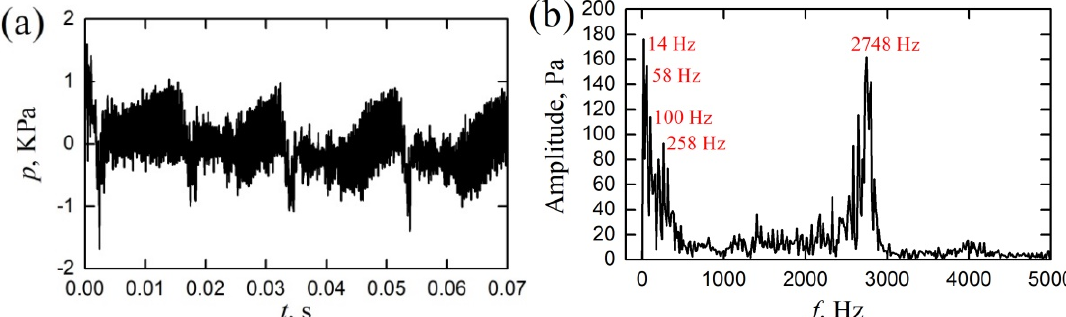
Figure 10. Flow field characteristics of the serpentine inlet at M = 0.235 and p AIP / p 0 = 0.85 under the no-gust condition: ( a ) the vortex tube (VT) structure, ( b ) Flow separation occurring at the lee side of the top surface coupled with the Mach number contour, ( c ) Total pressure contour at the AIP, and ( d ) Pattern of the secondary flow at the AIP.